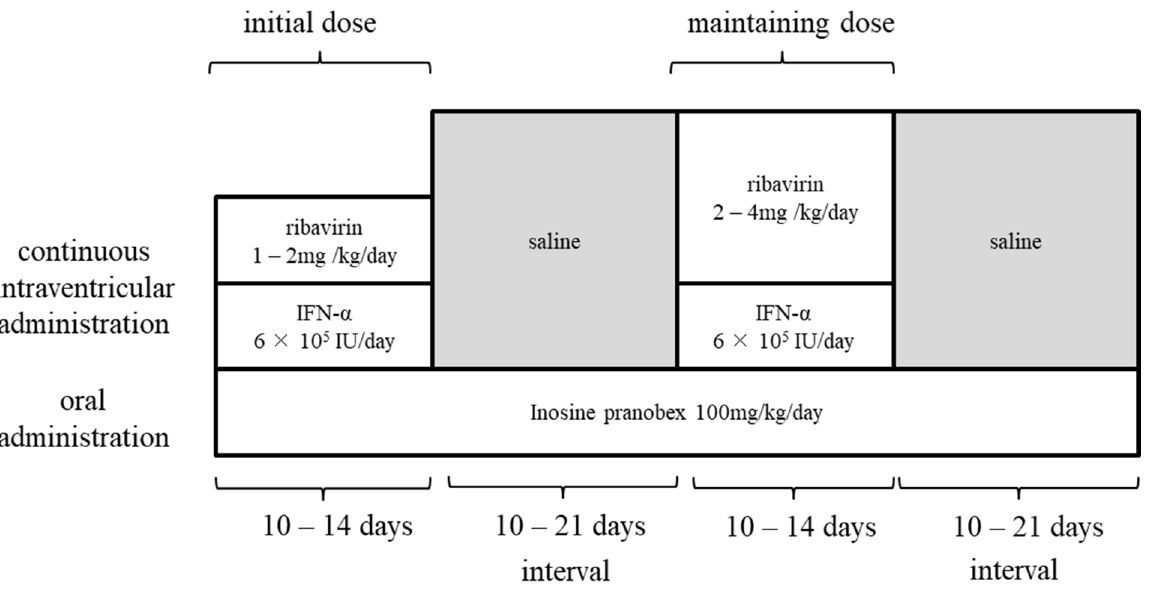
Figure 4. Protocol for ribavirin continuous infusion therapy using a continuous infusion pump. Patients were given ribavirin and interferon- α using a subcutaneous continuous infusion pump with oral administration of inosine pranobex (continuous administration therapy). At the start of the treatment, 1–2 mg/kg per day was used as the initial ribavirin dosage. Ribavirin dosage was raised according to its concentration in CSF and treatment cycles were repeated as maintenance doses